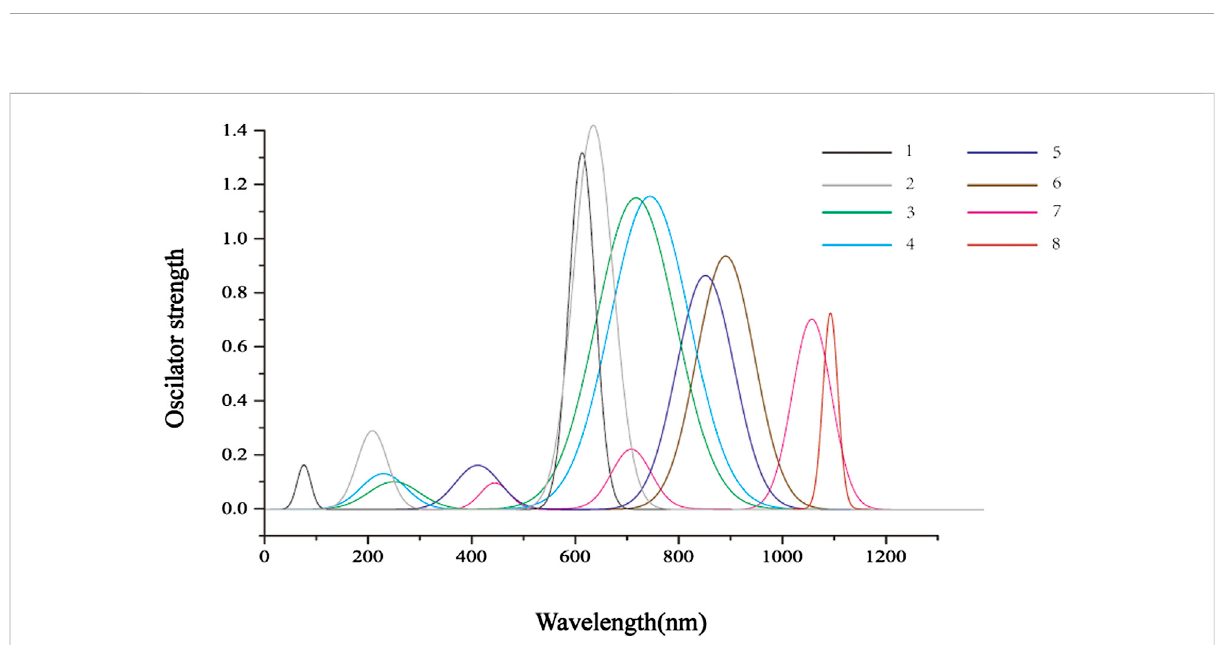
FIGURE 3 The simulated absorption spectra of molecules 1 – 8 were obtained using TD-DFT/CAM-B3LYP/6-311G (d,p) level of